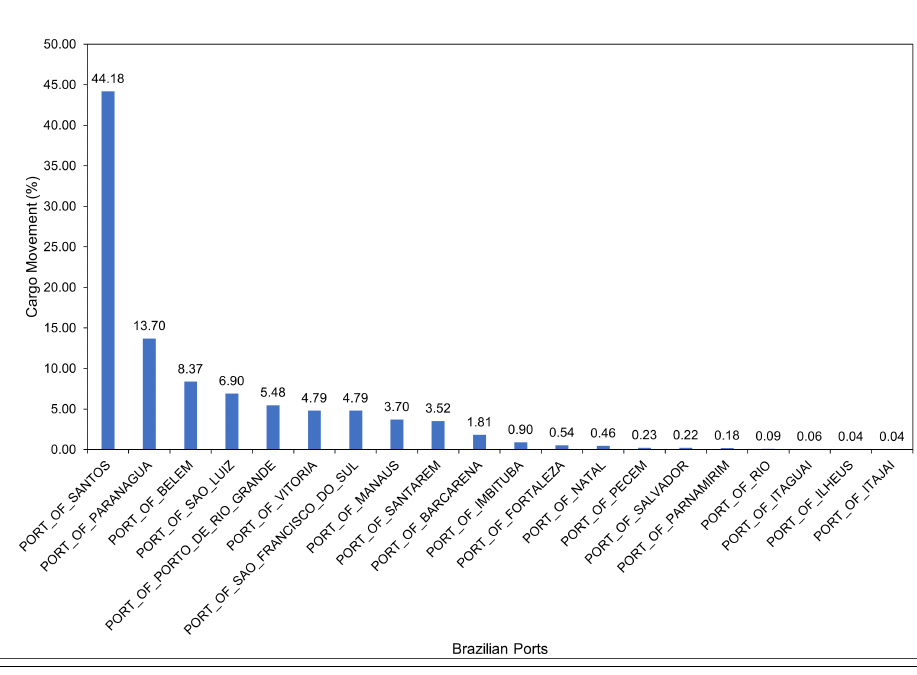
Figure 3. Brazilian ports by importance in cargo volume